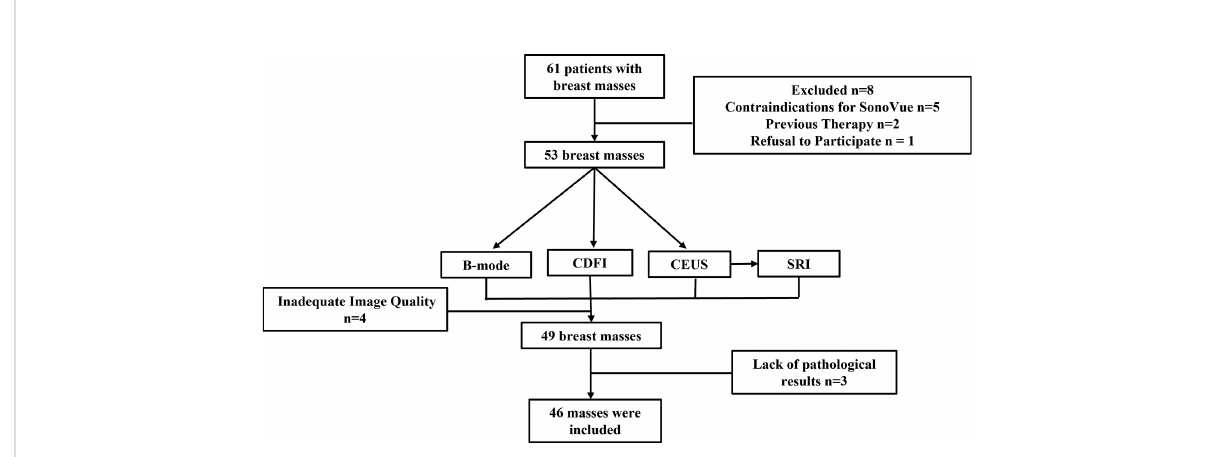
FIGURE 1 Flow chart of data